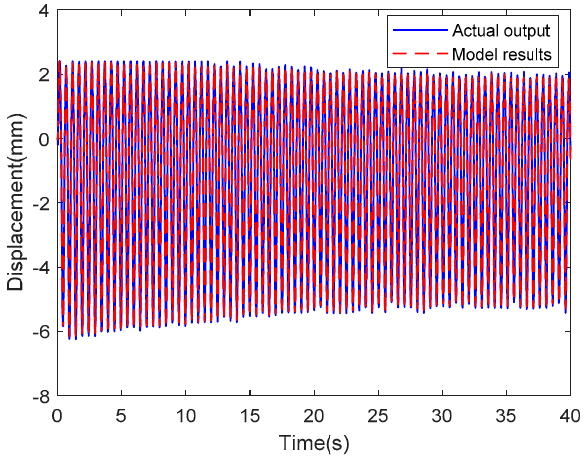
Figure 32. Results of the optimized LSSVM ‐ NARX model at sinusoidal actuating voltage with amplitude of 3V and frequency of 5/2 π Hz.